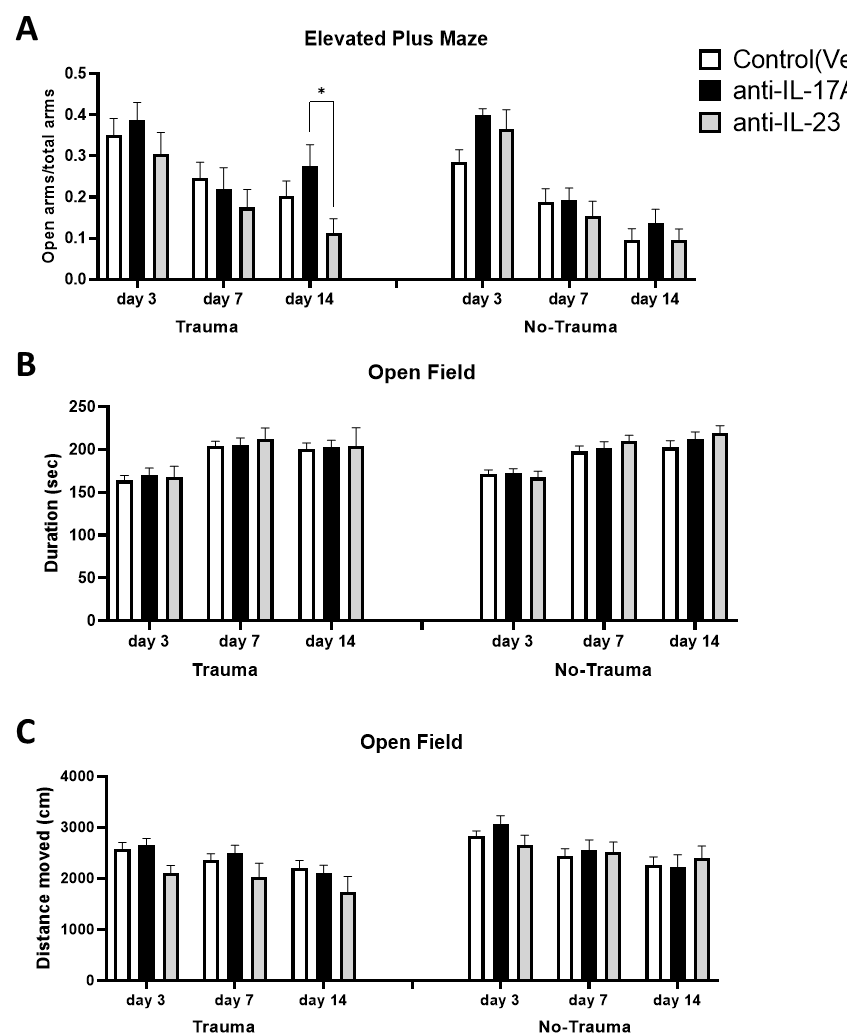
Figure 6. Exposure to trauma and antibody treatment do not affect general anxiety and locomotor activity. At days 3, 7, and 14 following the exposure to trauma, mice were subjected to elevated plus- maze and open field assays. General anxiety was measured in the elevated plus-maze assay where the preference of the tested mice for the open arms indicates for lower anxiety. ( A ) A graph presenting the ration of open arms duration to total arms duration of the various sub-groups. Similarly, the preference of the tested mice for the corners of the open field arena indicates for increased anxiety. ( B ) A graph presenting the duration the mice spent in the corners of the open field arena. ( C ) A graph presenting the total distance the mice travelled in the open field arena as an indication for locomotor activity. (Trauma: anti-IL-17A n = 16, anti-IL-23 n = 12, Control n = 24. No trauma: anti-IL-17A n = 17, anti-IL-23 n = 12, Control n = 24). All data in the graphs is presented as mean ± SE. * p < 0.05.